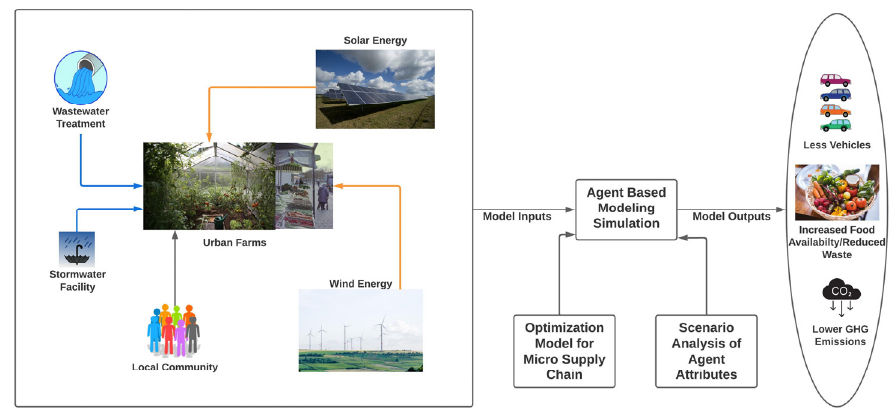
Figure 2. Proposed modeling framework with modeling inputs.